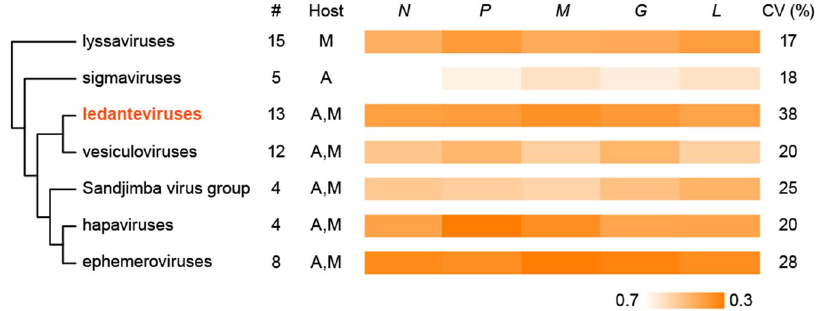
Figure 3. Relative dinucleotide frequency in seven rhabdovirus groups. Shading indicates relative CpG frequency of the canonical rhabdovirus nucleoprotein ( N ), phosphoprotein ( P ), matrix ( M ), glycoprotein ( G ) and polymerase ( L ) genes, averaged across viruses within each group. Scale (bottom) is inverted, so that darker colors indicate higher relative CpG depletion. Numbers indicate sample sizes of viruses per group, and letters indicate host associations of viruses within groups (A = arthropod; M = mammal). CV indicates the coefficient of variation (percent) of CpG across virus genomes within each group. The cladogram (left) shows non-metric evolutionary relationships among genera, based on 21 . Included in the analysis were all viruses with full L , P , G , M and L gene sequences available in GenBank and the Virus Pathogen Resource database 58 as of December 12, 2016 (Supplementary Table